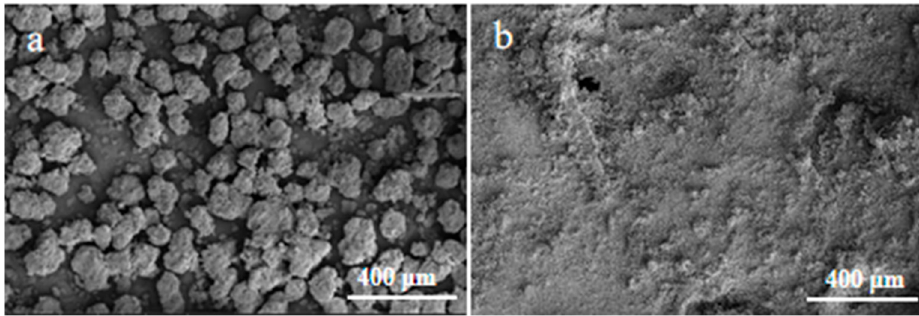
Figure 3. SEM images of the inactivated sample ( a ) and mechanically activated sample ( b ).